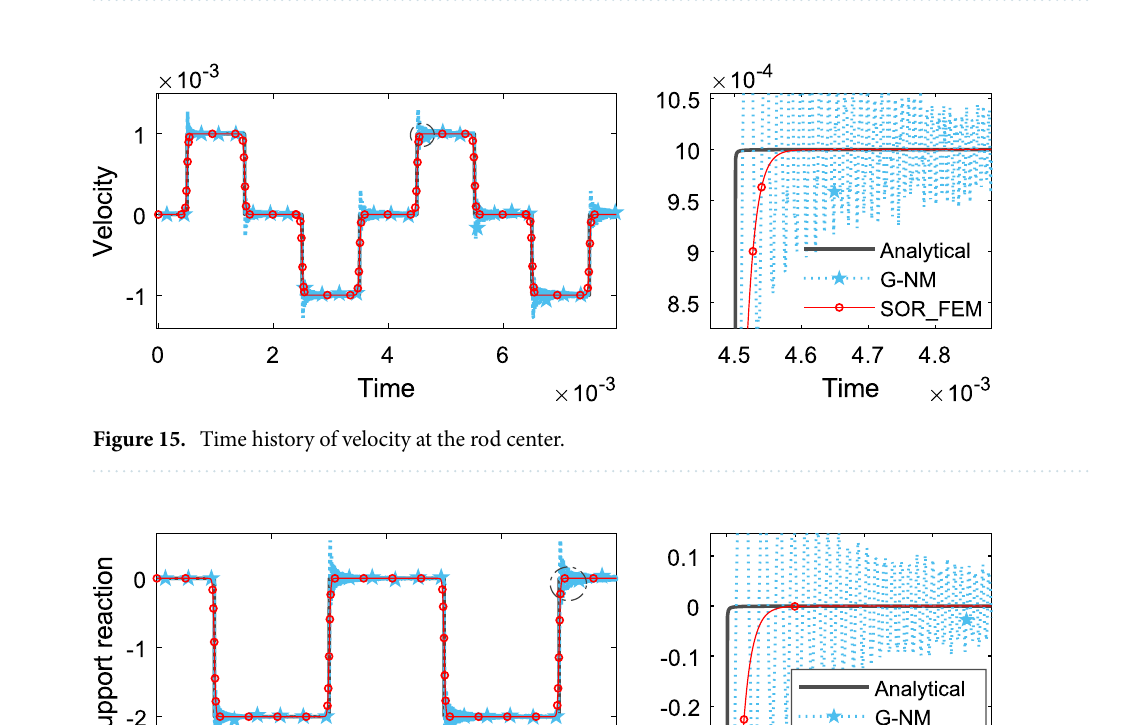
Figure 14. Time history of displacement at the rod center.